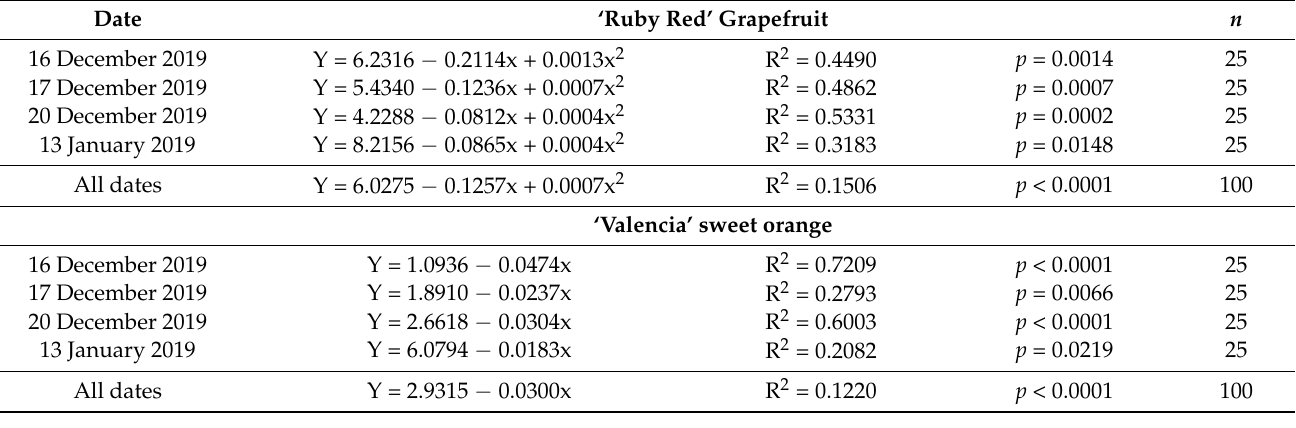
Table 2. Adjustment equations, coefficients of determination (R 2 ), and probability (P) values of the regressions for the temperature difference ( ∆ T).